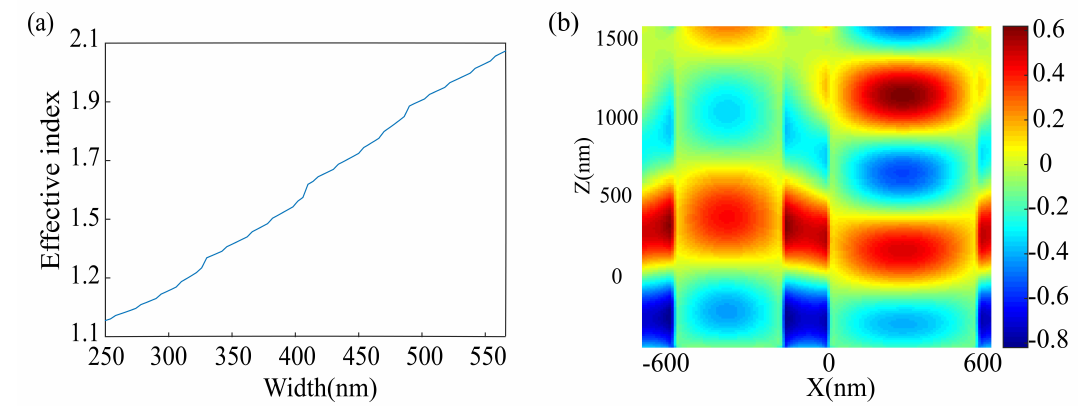
Figure 3. ( a ) E ff ective index of a single square silicon nitride (SSN) nanopillar as a function of its width ( w ) for x-LPL incidence ( E x ). ( b ) Side views of the electric field (real [Ex]) distribution in two SSN nanopillars with di ff erent widths (400 nm, 560